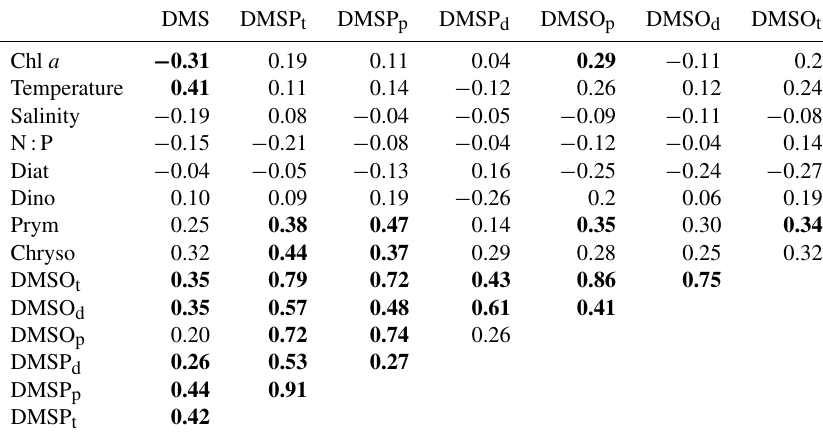
Table 1. Spearman’s rank correlation coefficients of correlations of all sulfur compounds with several ambient parameters, as well as algae groups in the mixed layer at BE during 2009–2018. Only datasets were used for which all environmental parameters ( n = 85), phytoplankton data ( n = 61 for diatoms and dinoflagellates, n = 48 for chrysophytes, and n = 35 for prymnesiophytes) were available, and data were averaged for the mixed layer. Bold numbers indicate that a correlation is significant at the 0.01 level (two tailed). Diat, dino, prym and chryso stand for diatoms, dinoflagellates, prymnesiophytes and chrysophytes, respectively. N:P ratios stand for the ratio of the sum of nitrate, nitrite and ammonium to phosphate. DMS DMSP